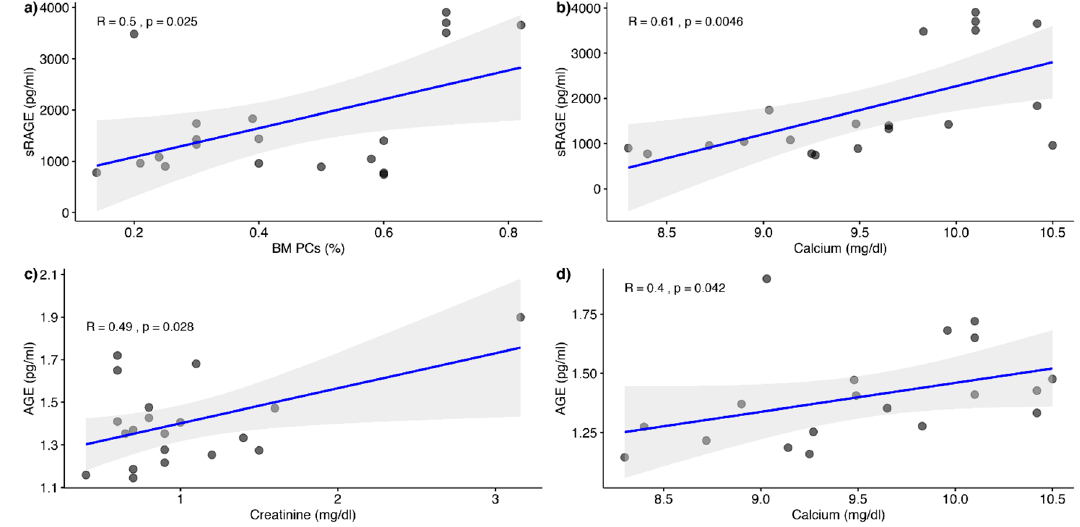
Figure 4. Correlation between AGE/RAGE vs significant blood parameters.